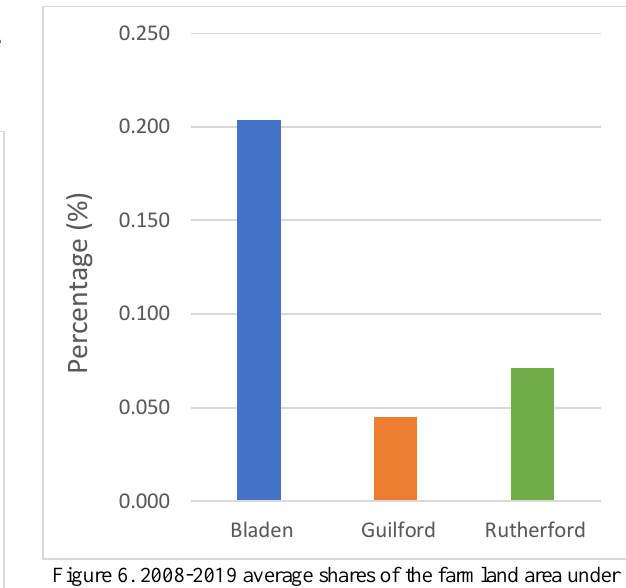
Figure 6. 2008-2019 average shares of the farmland area under VP